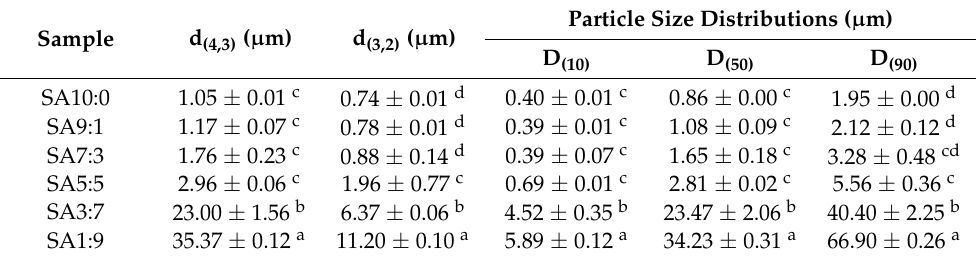
Table 4. The mean particle size and size distribution of sodium caseinate-acetylated mung bean starch–lutein microcapsules.